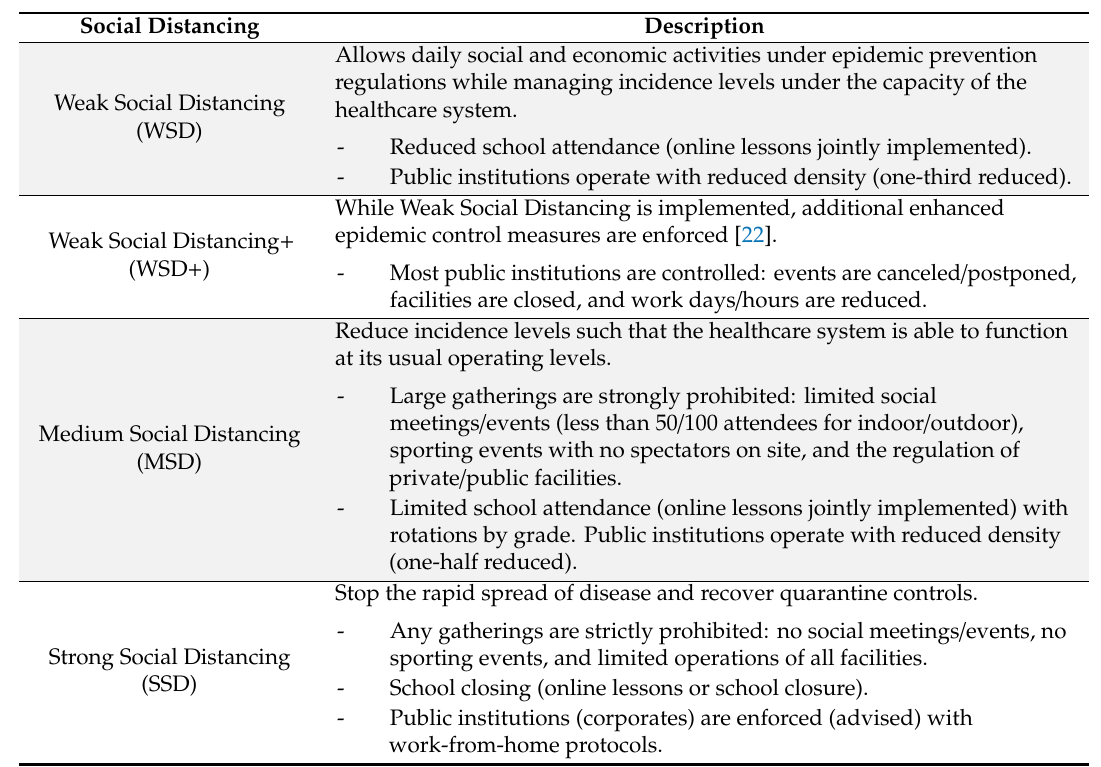
Table 2. Description of the different levels of social distancing.